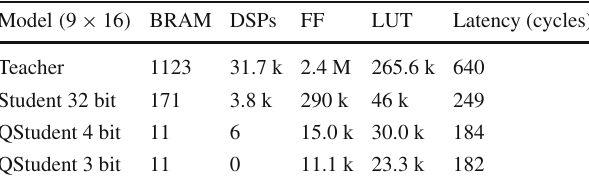
Fig. 14 Fake Efficiency for events with no muon tracks but only back- ground as a function of the number of bits per weight. In indigo (circles) the performance of the Teacher model. In light green (triangles) the per- formance of the Student trained without any help from the Teacher. In red (squares) the performance of the Student trained with hints from the Teacher. The Teacher Fake Efficiency remains 0 for all level of quantization Table 2 Resources occupancies for different FPGA components and latencies in clock cycles (2.38 ns requested clock in